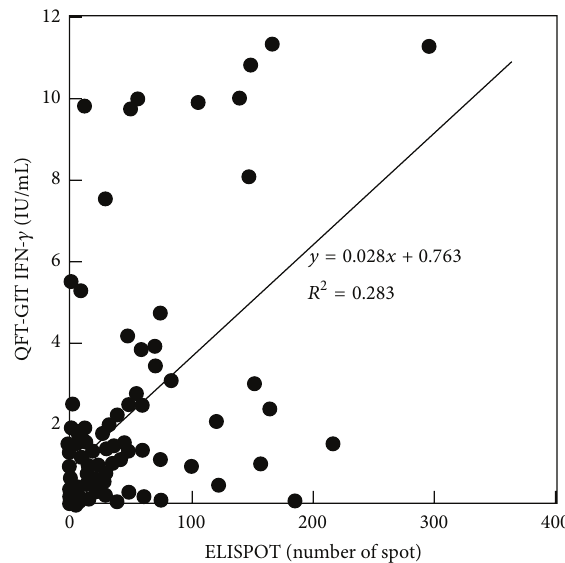
Figure1:AssociationbetweenQFT-GITvaluesandnumberofspots in the ELISPOT assay ( 𝑟 = 0.532 ; 𝑃 < 0.001